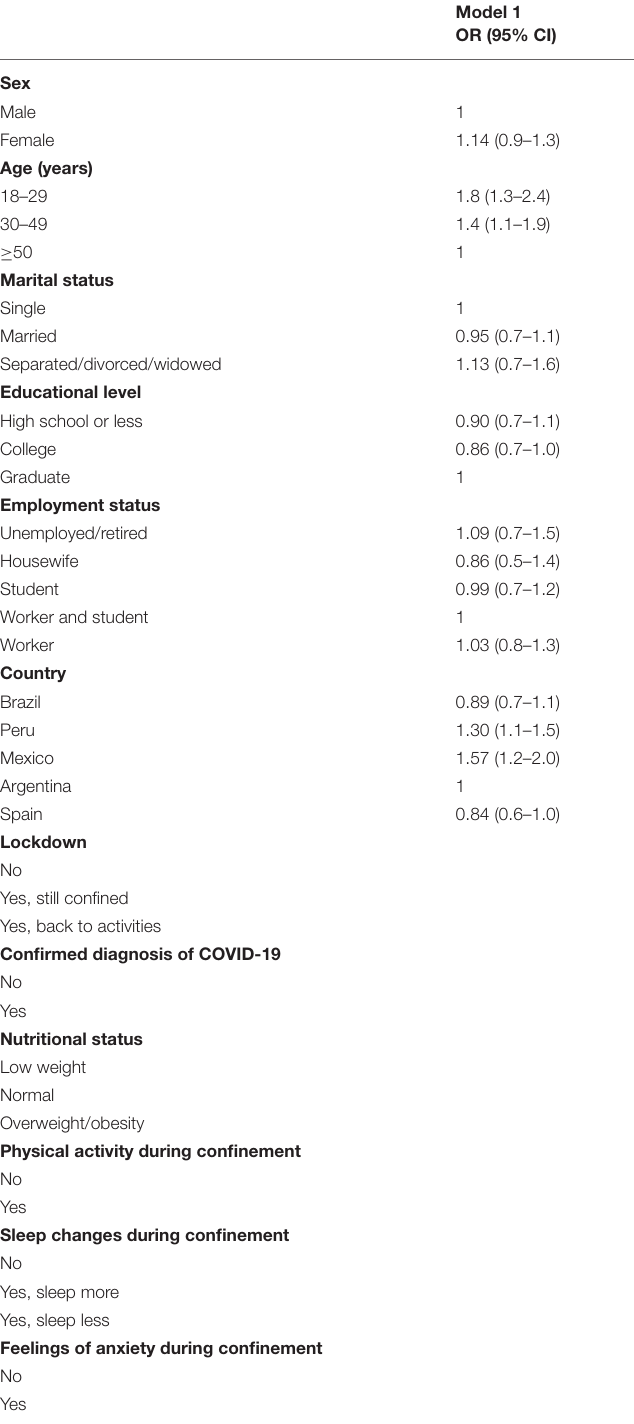
TABLE 5 | Comparison of selected variables among participants who changed their eating patterns toward less healthy choices during the COVID-19 pandemic ( n = 996). a .